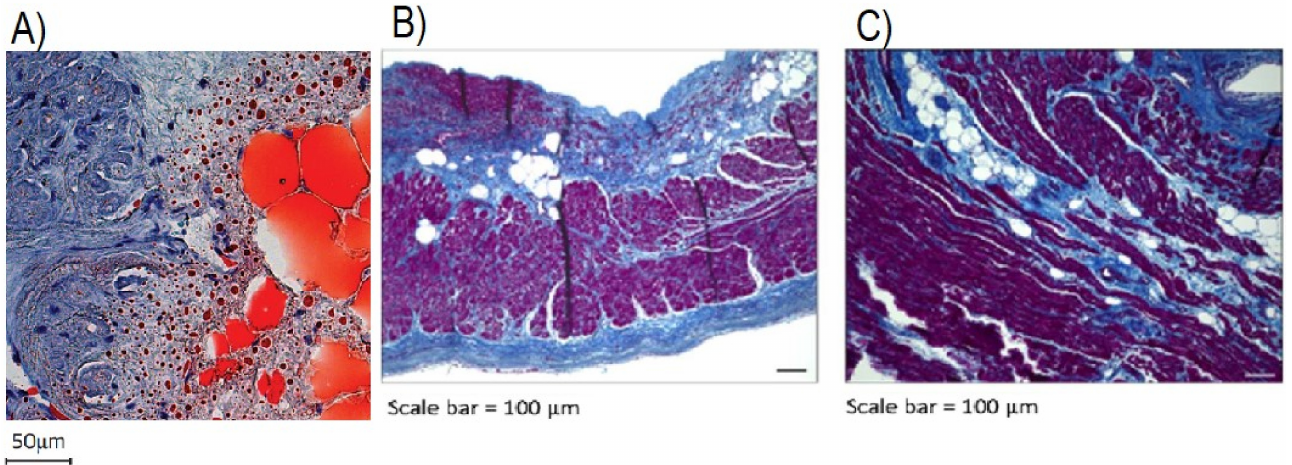
Figure 4. ( A ): Oil-red-O-stained RAA sections depicting heterogenous interface between infiltrating adipose tissue (red, globular cells) and myocardium (blue). ( B , C ): LAA sections stained with HE shows significant EAT infiltration (empty, globular cells) with fibrosis (blue strands) noted along adipocytes. Myocardium is represented as magenta. ( A ) Reproduced with permission from Nalliah et al. [68]; ( B , C ) reproduced with permission from Abe et al.